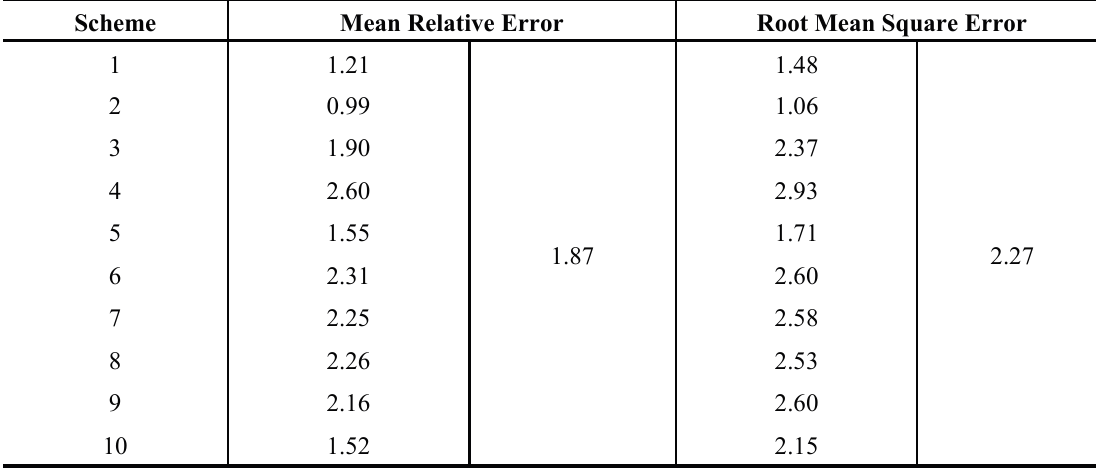
Table 4. The mean relative error and root mean square error between the simulation model and surrogate